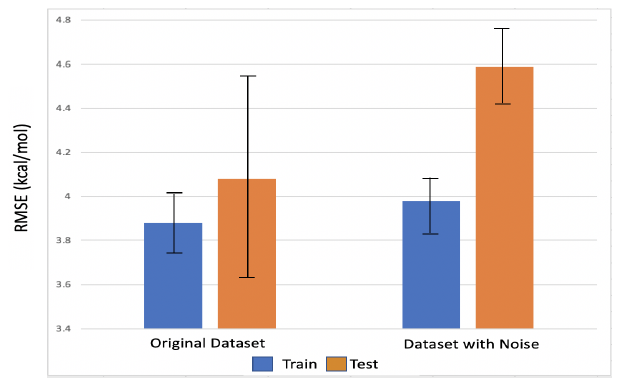
Figure 5. Error in calculating ∆∆ G values on data with added noise compared to the original data.